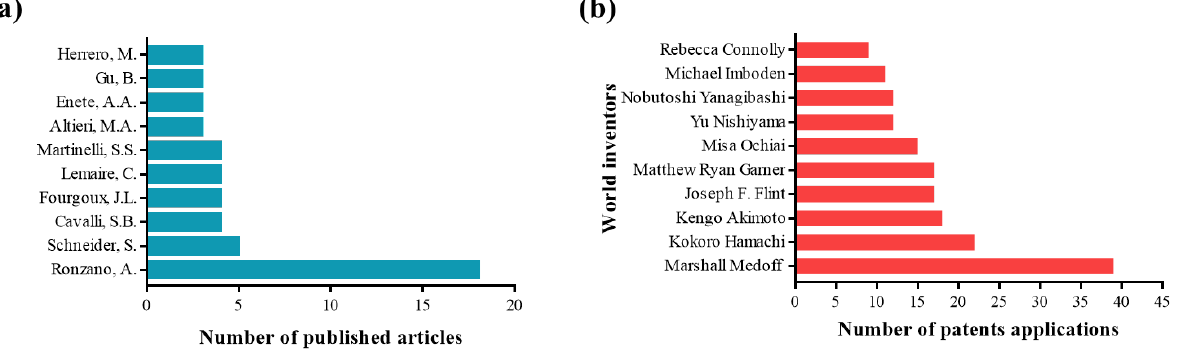
Figure 6. Distribution of the top 10 authors of published articles ( a ) and inventors of filed patents ( b ) related to the participation of family farming in the development of new food products.